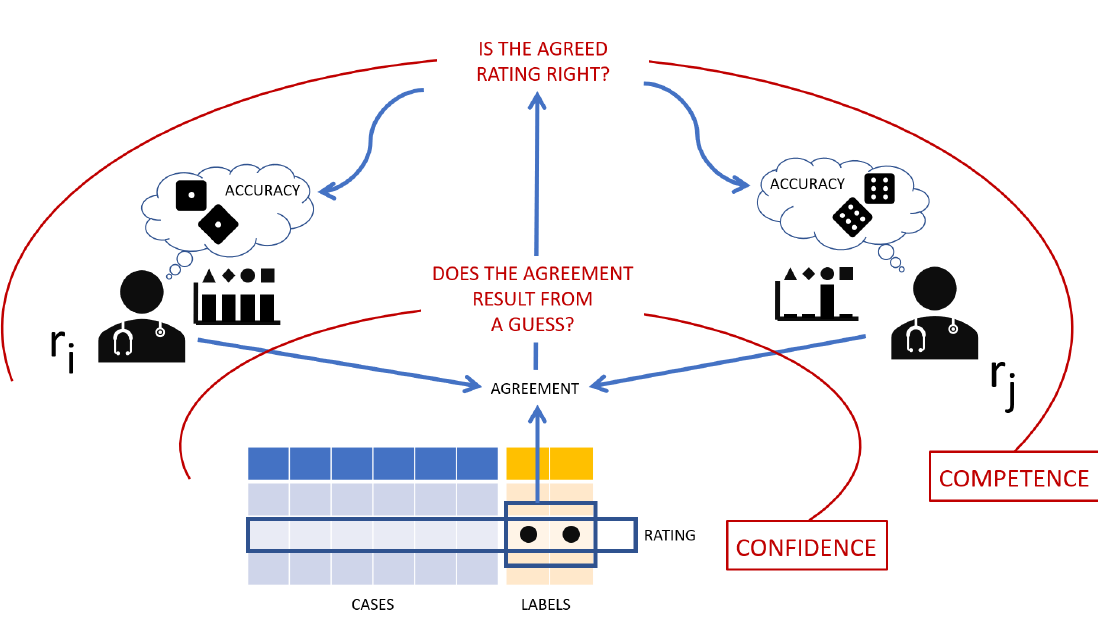
Figure 6. Graphical presentation of the general idea of the weighted reliability score, (cid:36) . This reliability score is multi-dimensional as it encompasses both the confidence of the raters and their competence. In this graphical example, rater r i is much less competent than rater r j , and hence, the probability that her/his rating is correct is